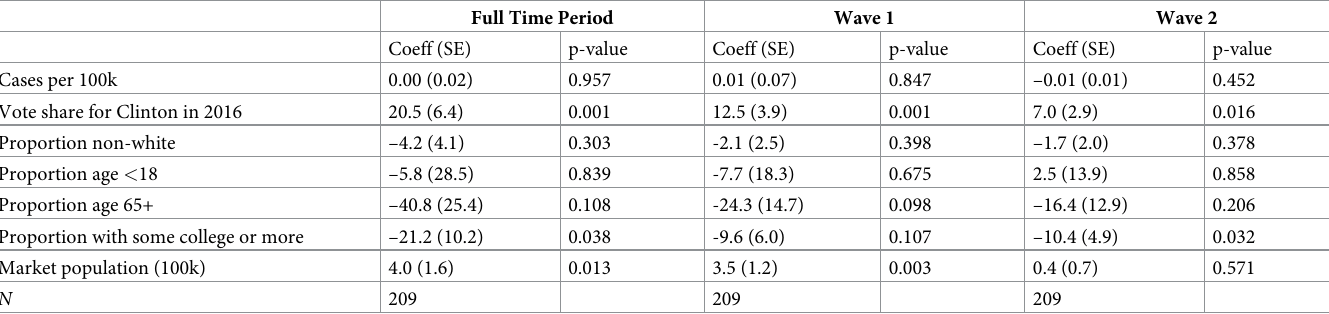
Table 1. Association of PSA airings and market-level factors, overall and by pandemic